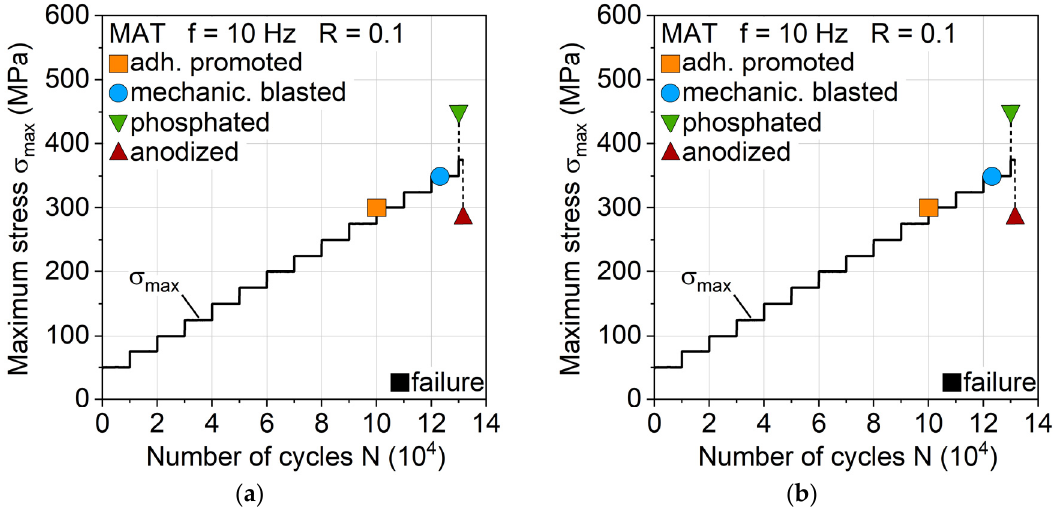
Figure 9. Influence of aluminum surface treatment on ( a ) fatigue strength and life and ( b ) change in temperature during multiple amplitude tests.